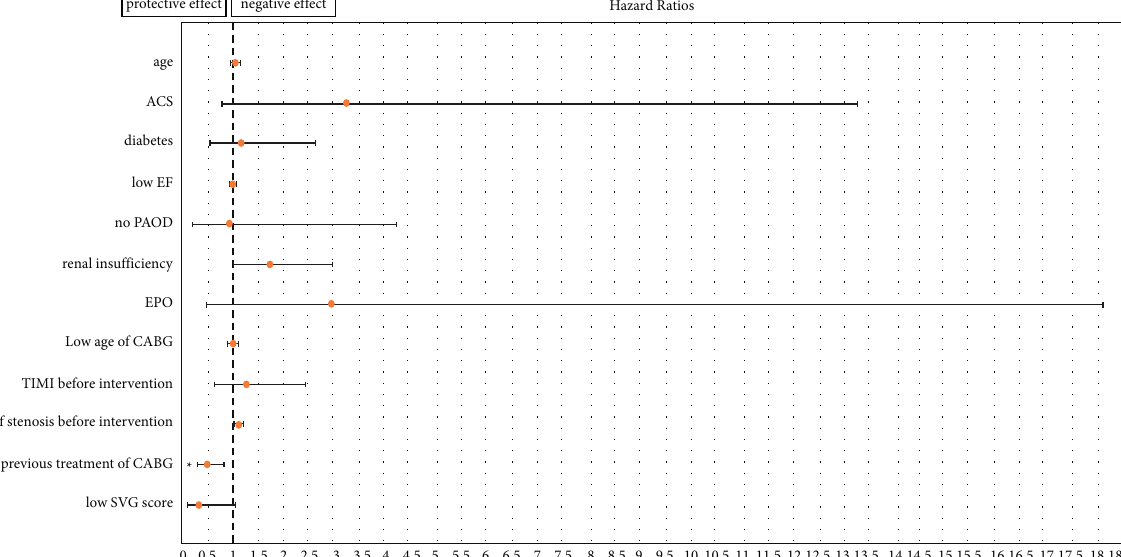
Figure 6: Forest plot depicting hazard ratios of several covariates. Statistical signifcance ( p < 0 . 01) marked with a star. A hazard ratio < 1 illustrates a protective efect on patient outcome, whereas a hazard ratio > 1 represents a negative efect. ACS � acute coronary syndrome; EF � ejection fraction; PAOD � peripheral artery occlusive disease, EPD � embolic protection device; CABG � coronary artery bypass graft; TIMI � thrombolysis in myocardial infarction; and SVG � saphenous vein